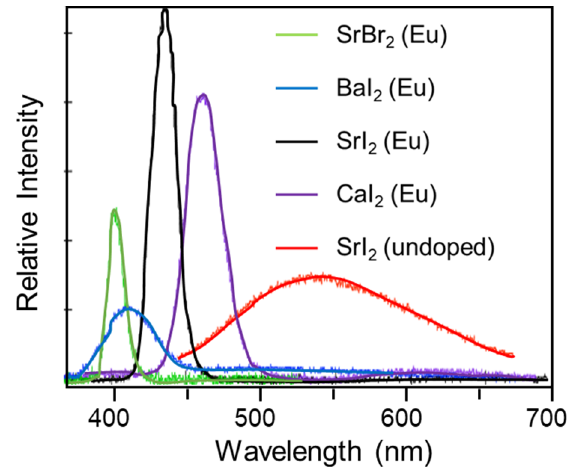
Figure 5. Examples of beta-excited radioluminescence spectra of several alkaline earth halide crystals. Reproduced from Reference [42] with permission.